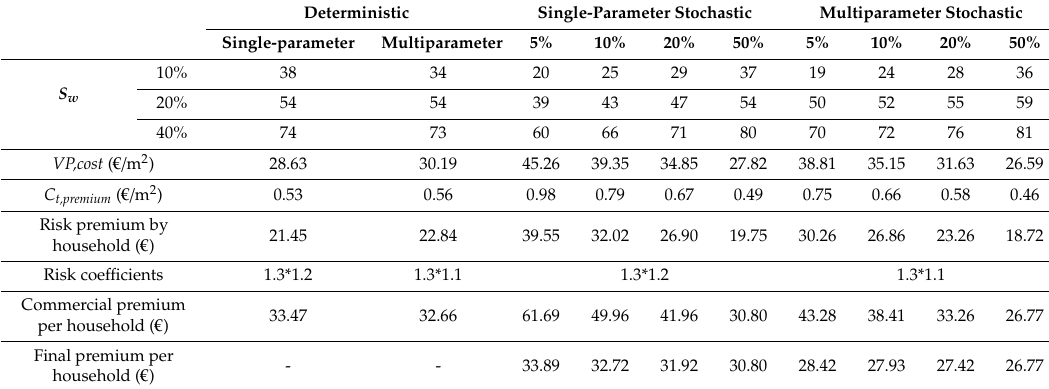
Table 8. Summary table with estimated times before action, costs, risk premium rates, risk premiums, risk coe ffi cients, and commercial premiums per household for the di ff erent